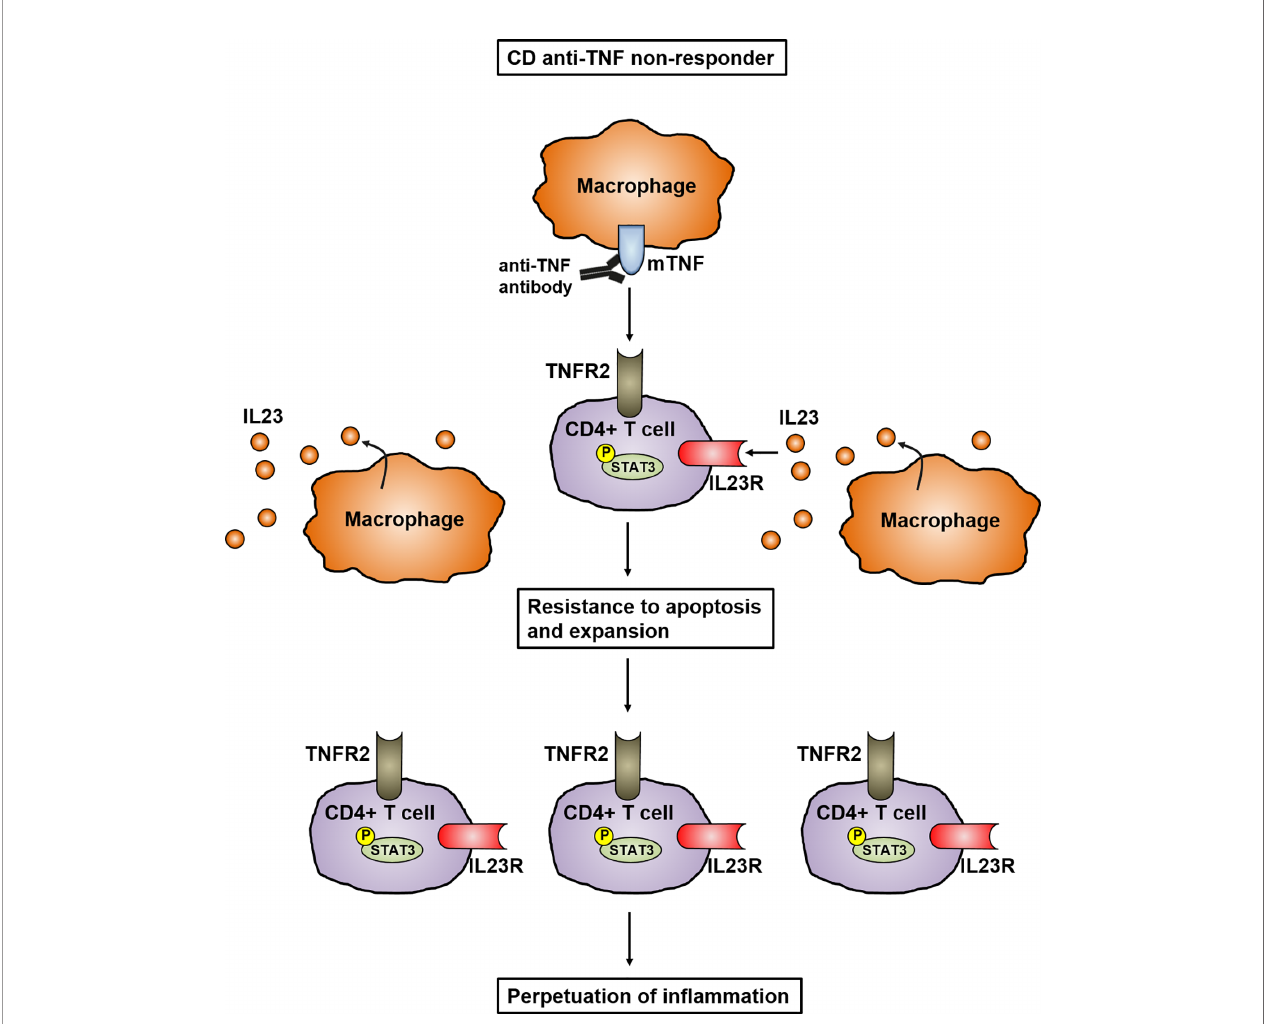
FIGURE 2 | Model of IL23 mediated resistance to apoptosis of mucosal CD4+ T cells in anti-TNF refractory Crohn ’ s disease patients. In anti-TNF refractory patients, TNFR2 bearing gut CD4+ T cells express the IL23R. Heightened production of IL23 from CD14+ macrophages leads to binding to the IL23R on CD4+TNFR2+ T cells and induction of STAT3 activation. This activation leads to the expansion of CD4+IL23R+TNFR2+ T cells that are resistant to apoptosis induction by anti-TNF antibodies, resulting in the perpetuation of mucosal in fl